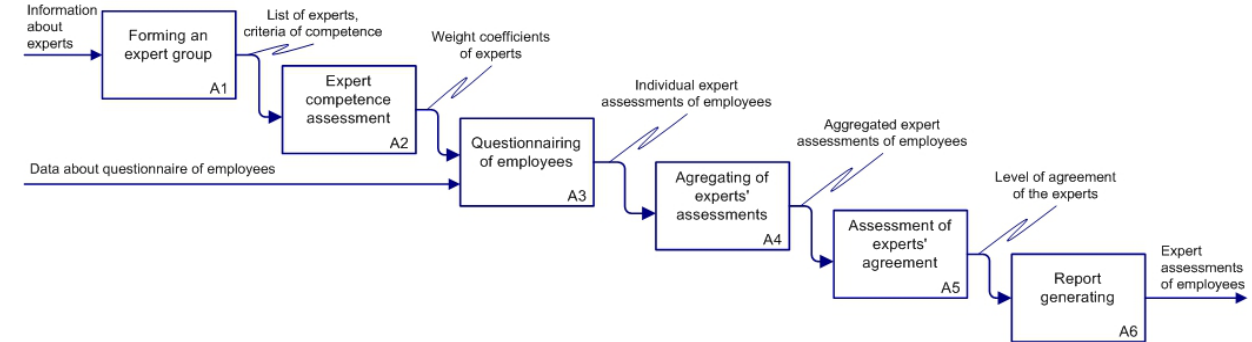
Figure 4. Functional diagram of the organization of the expert group work.